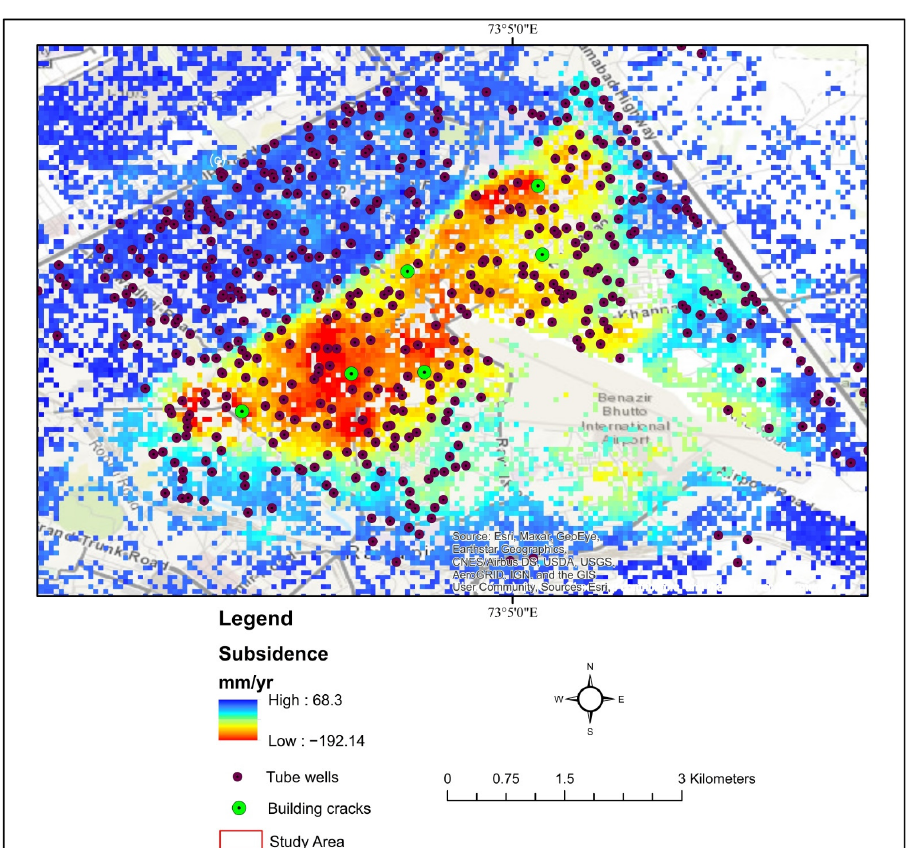
Figure 16. Tube-well location map of the investigated area.